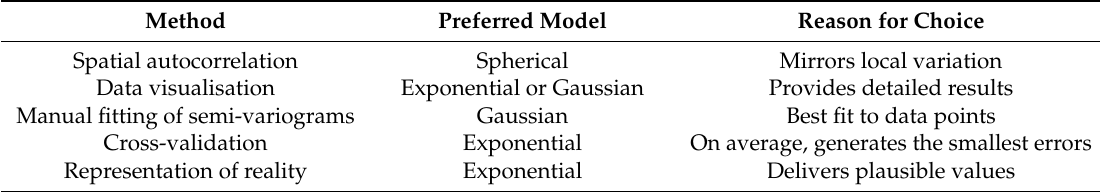
Table 1. Results of five methods of selection of theoretical semi-variogram.